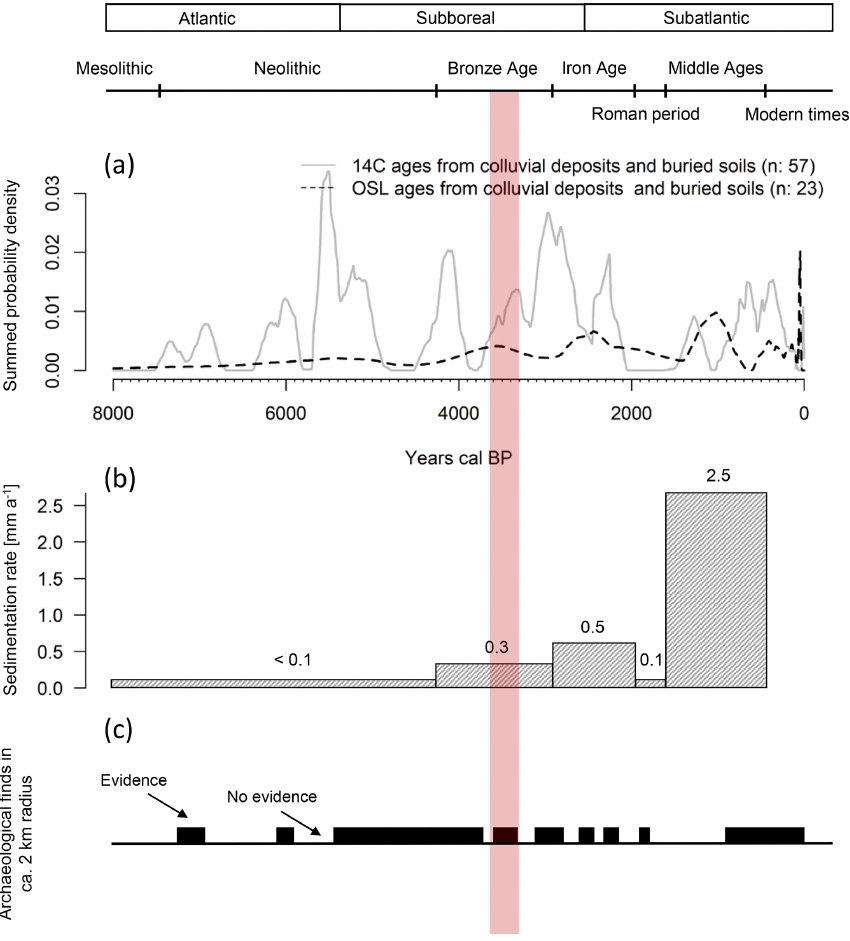
Figure 15. Summed probability density (SPD) curves from AMS 14 C and OSL ages (a) . Sedimentation rate by depositional ages (OSL) and related to archaeological periods (b) . Evidence of archaeological finds within a radius of 2km from the Anselfingen settlement site (c) . The red bar marks the Middle Bronze Age